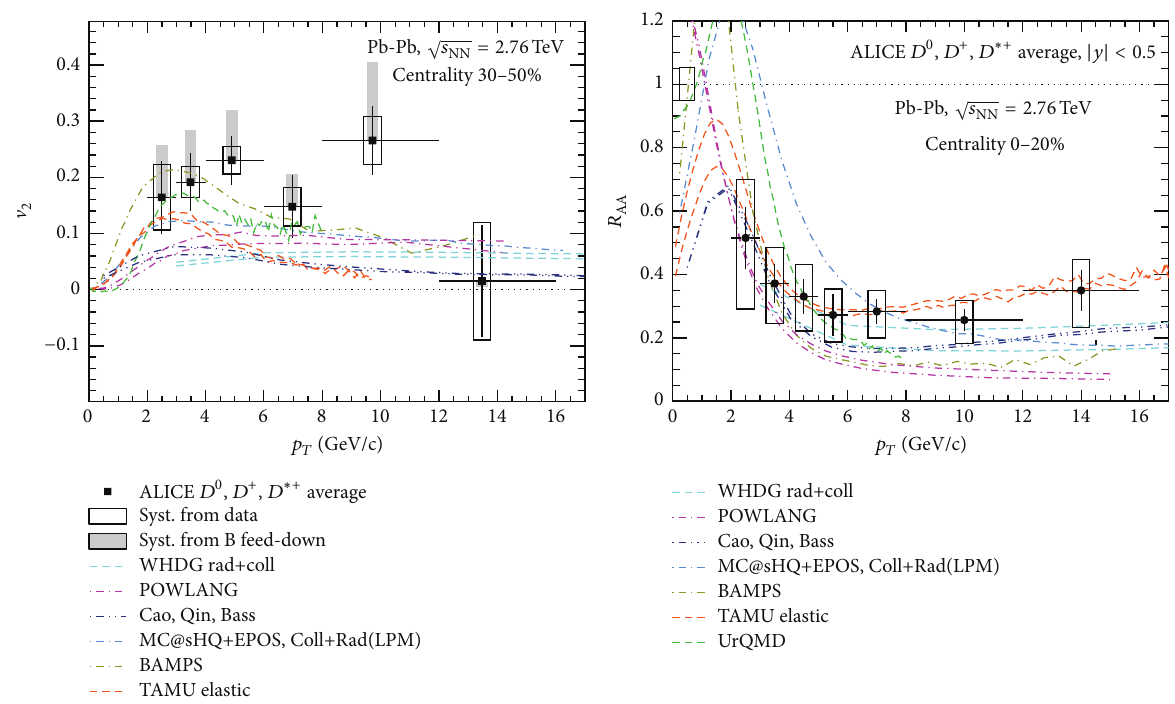
Figure 7: 𝐷 -mesons V 2 and 𝑅 AA in 30–50% semicentral Pb-Pb collisions at √𝑠 NN = 2.76 TeV and comparison with selected theoretical models [26,